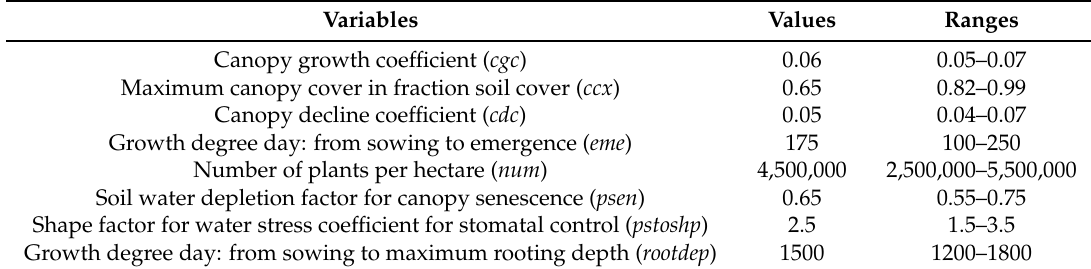
Table 4. Initial values and ranges of calibration parameters, or initial data, of the AquaCrop model.